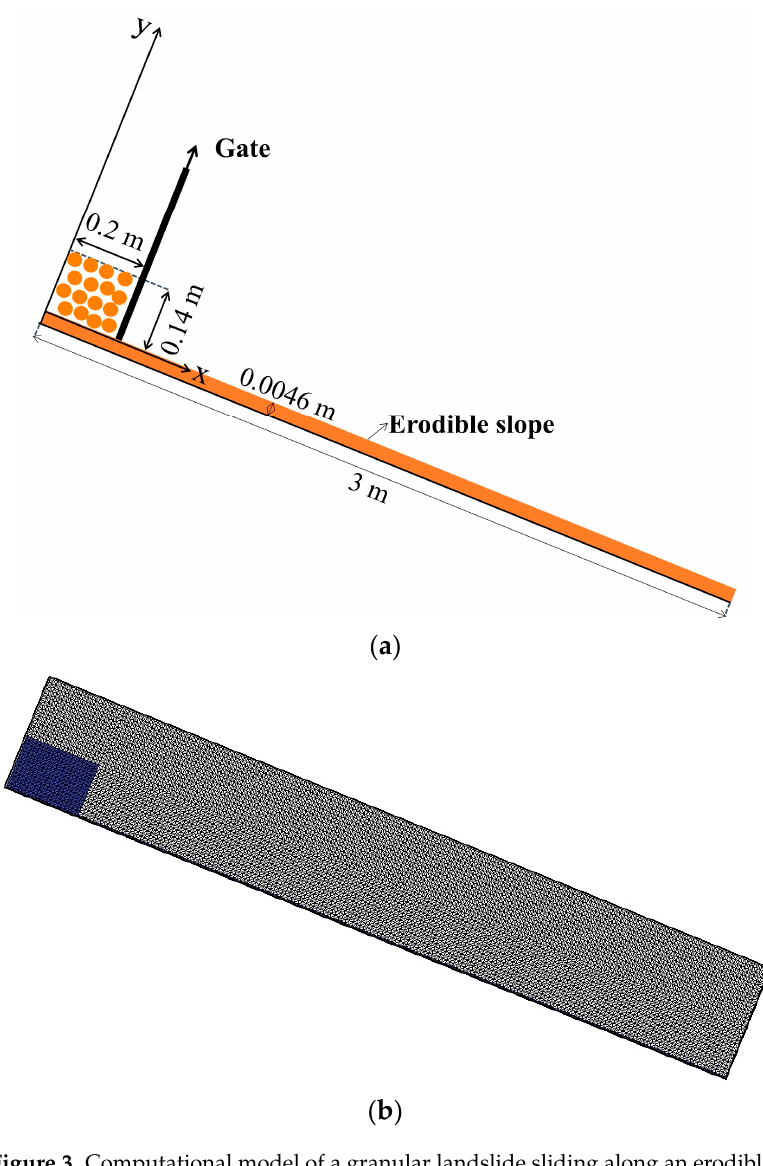
Figure 3. Computational model of a granular landslide sliding along an erodible slope: ( a ) Schematic of the initial model; ( b ) MPM discretization.